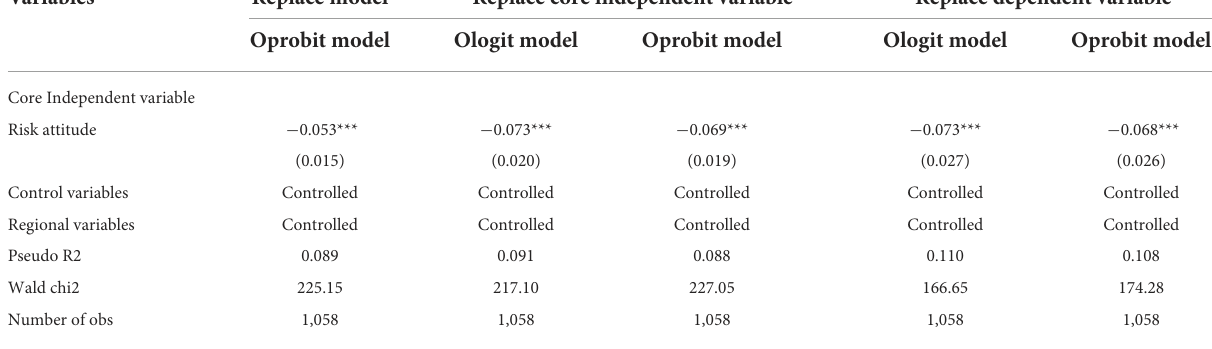
TABLE 5 Results of robustness